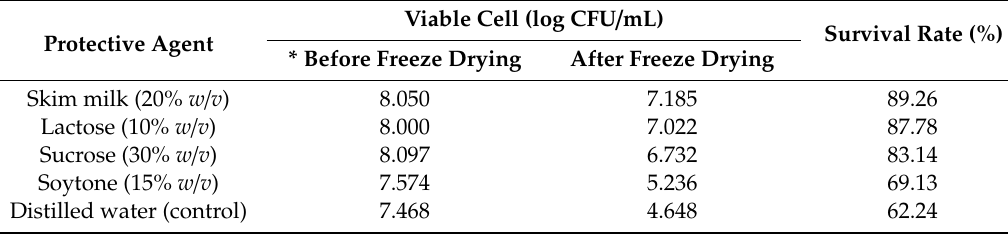
Table 1. Effect of protective agents on cell viability of P. polymyxa Kp10 before and after freeze-drying. Viable Cell (log CFU/mL) Protective Agent * Before Freeze Drying After Freeze Drying Skim milk (20% w/v )